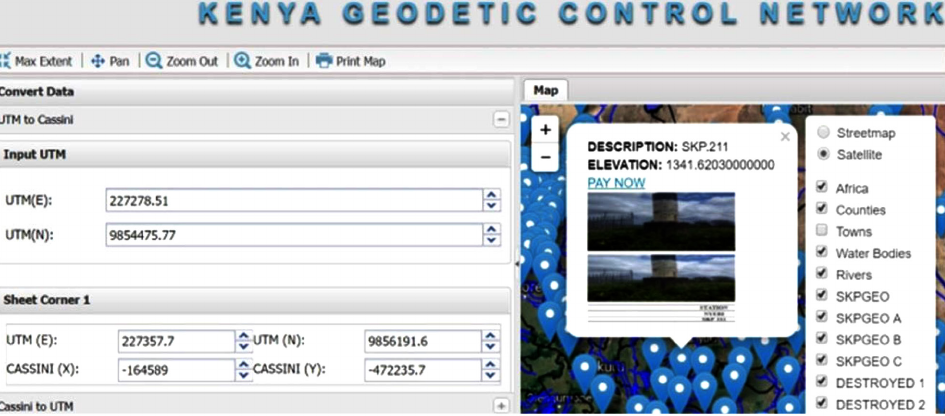
Figure 7. Coordinates conversion